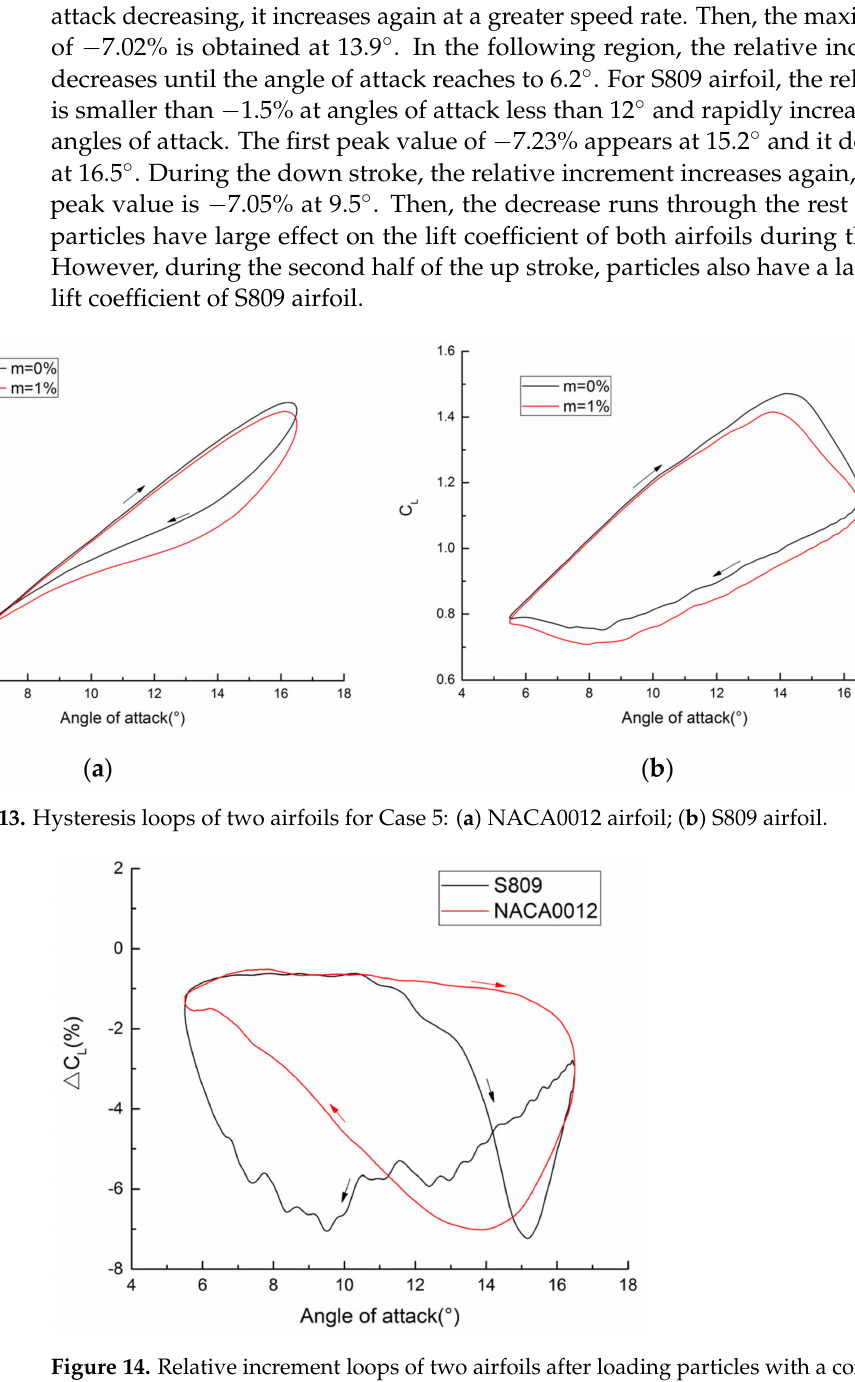
Figure 14. Relative increment loops of two airfoils after loading particles with a concentration of